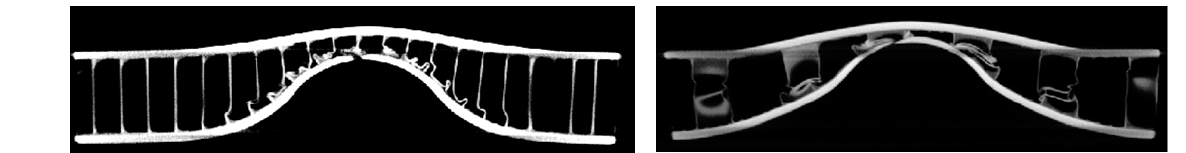
Figure 17: Tomographic images of the damaged honeycomb core panels after the impact ( d = 3 and 6 mm, v = 4 m/s). The values of energy required to produce the complete failure of the investigated composites are reported in Fig. 18.